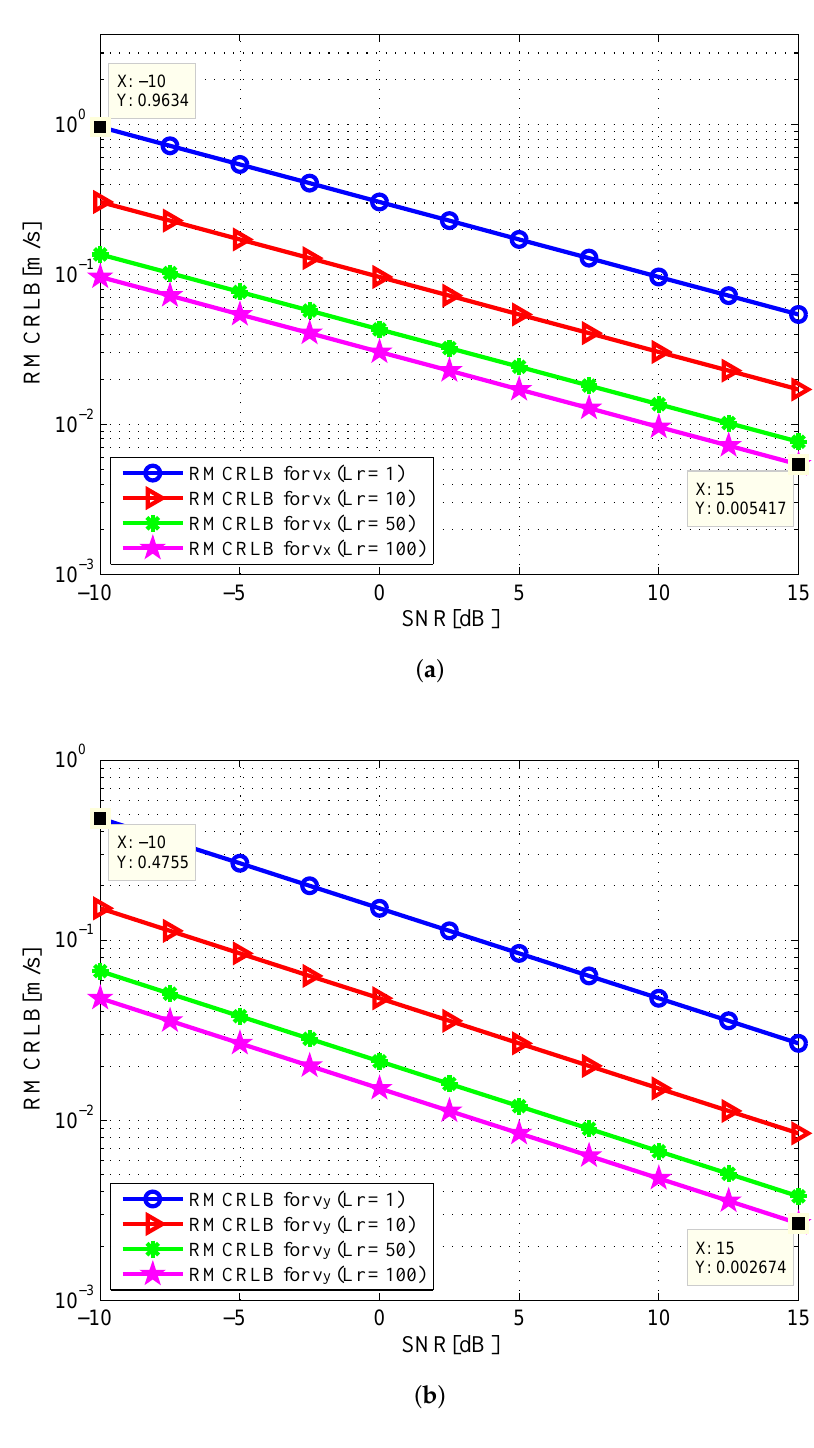
Figure 7. RMCRLB versus SNR in the target velocity dimensions with different L r when N = 1024 × 512: ( a ) x-velocity; ( b )